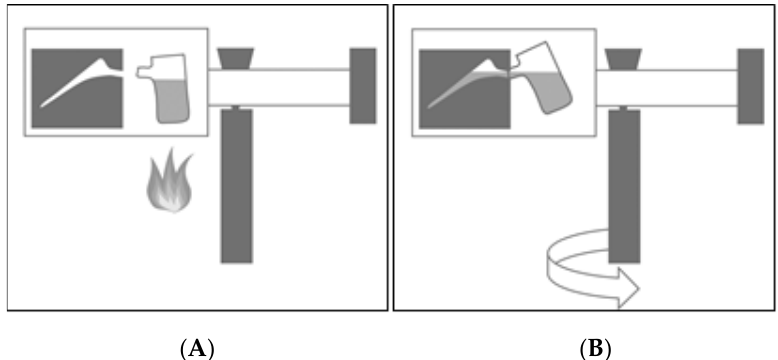
Figure 1. Schematic illustration of a centrifugal precision casting unit: The ingot-casting material is melted ( A ) and the liquid melt is then pressed into the casting mould by rotating the casting arm around a vertical shaft ( B ).